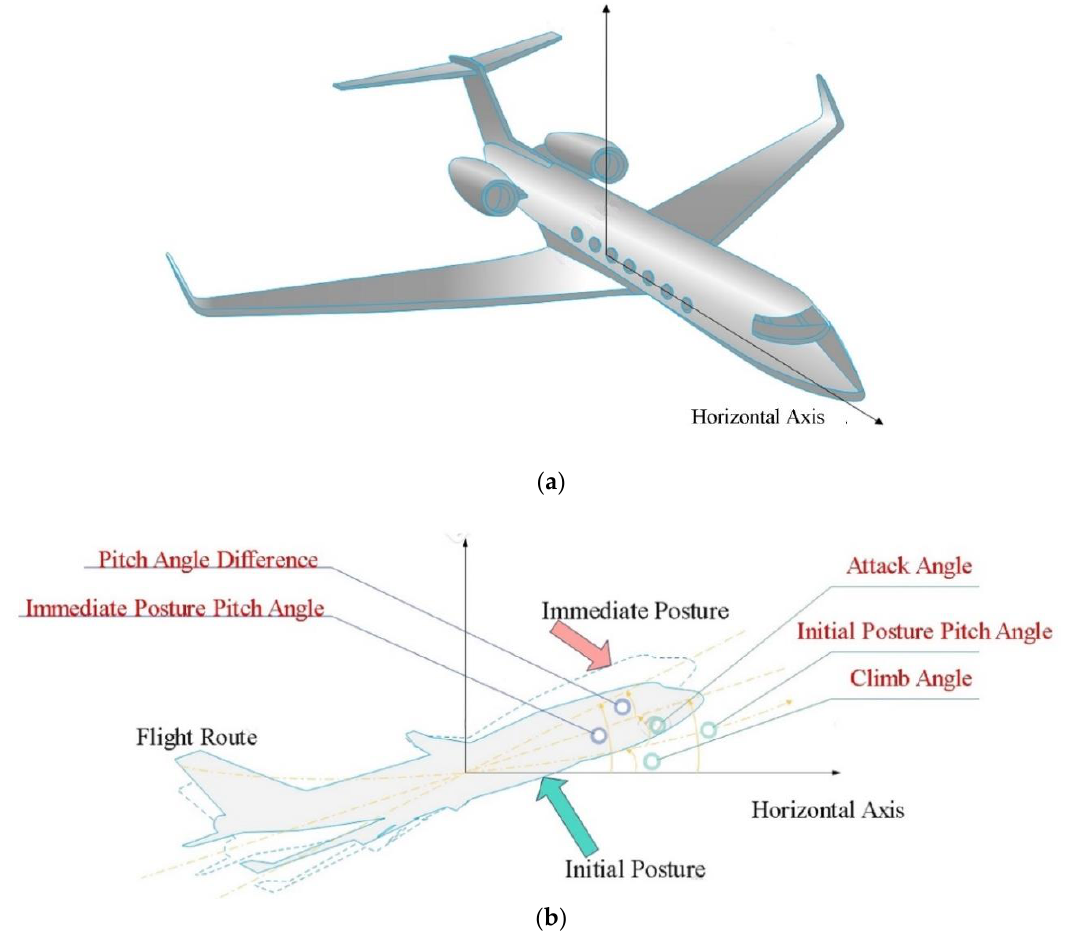
Figure 2. Schematic diagram of the elastic aircraft model. ( a ) the establishment of a flexible aircraft coordinate system; ( b ) schematic diagram of the mathematical model (Equation (1)). Among them, pitch angled difference represents physical quantity θ ( t ), and pitch angle is equal to climb angle plus attack angle ( α